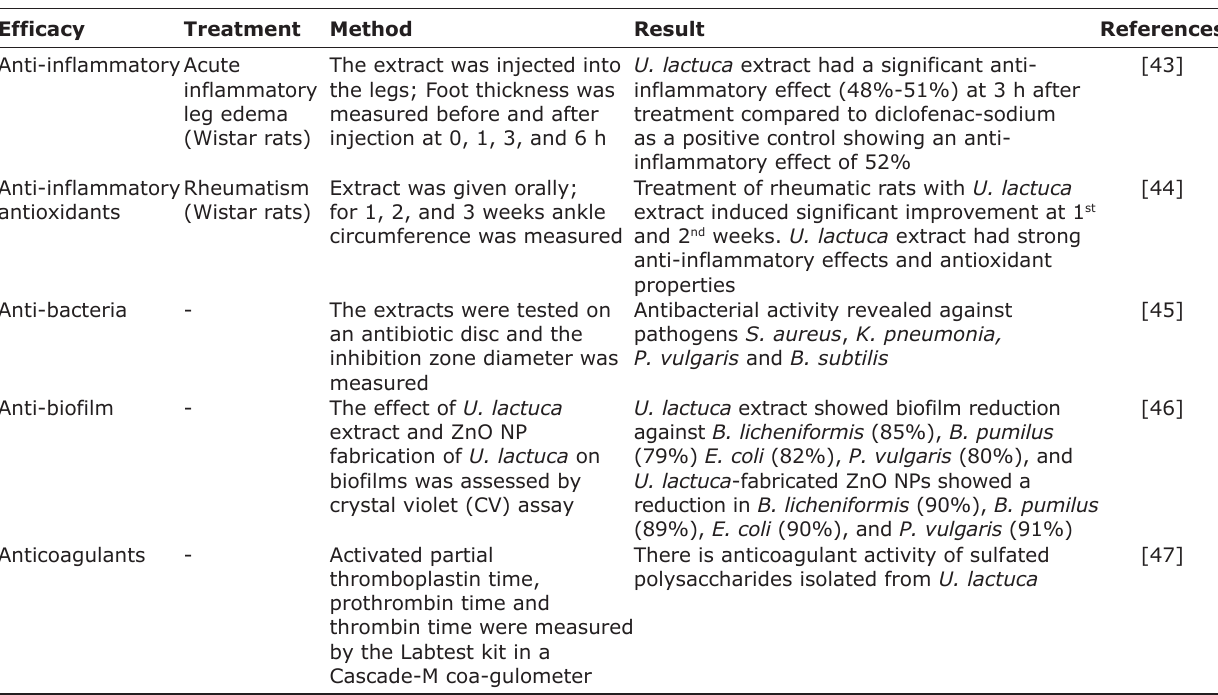
Table-3: Benefits of U. lactuca. Efficacy